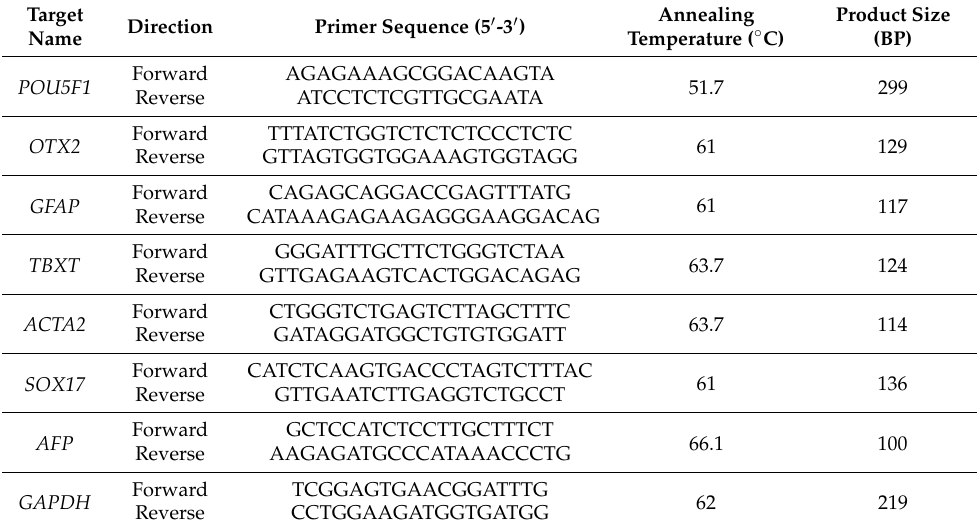
Table 2. RT-PCR primer sequences for gene expression